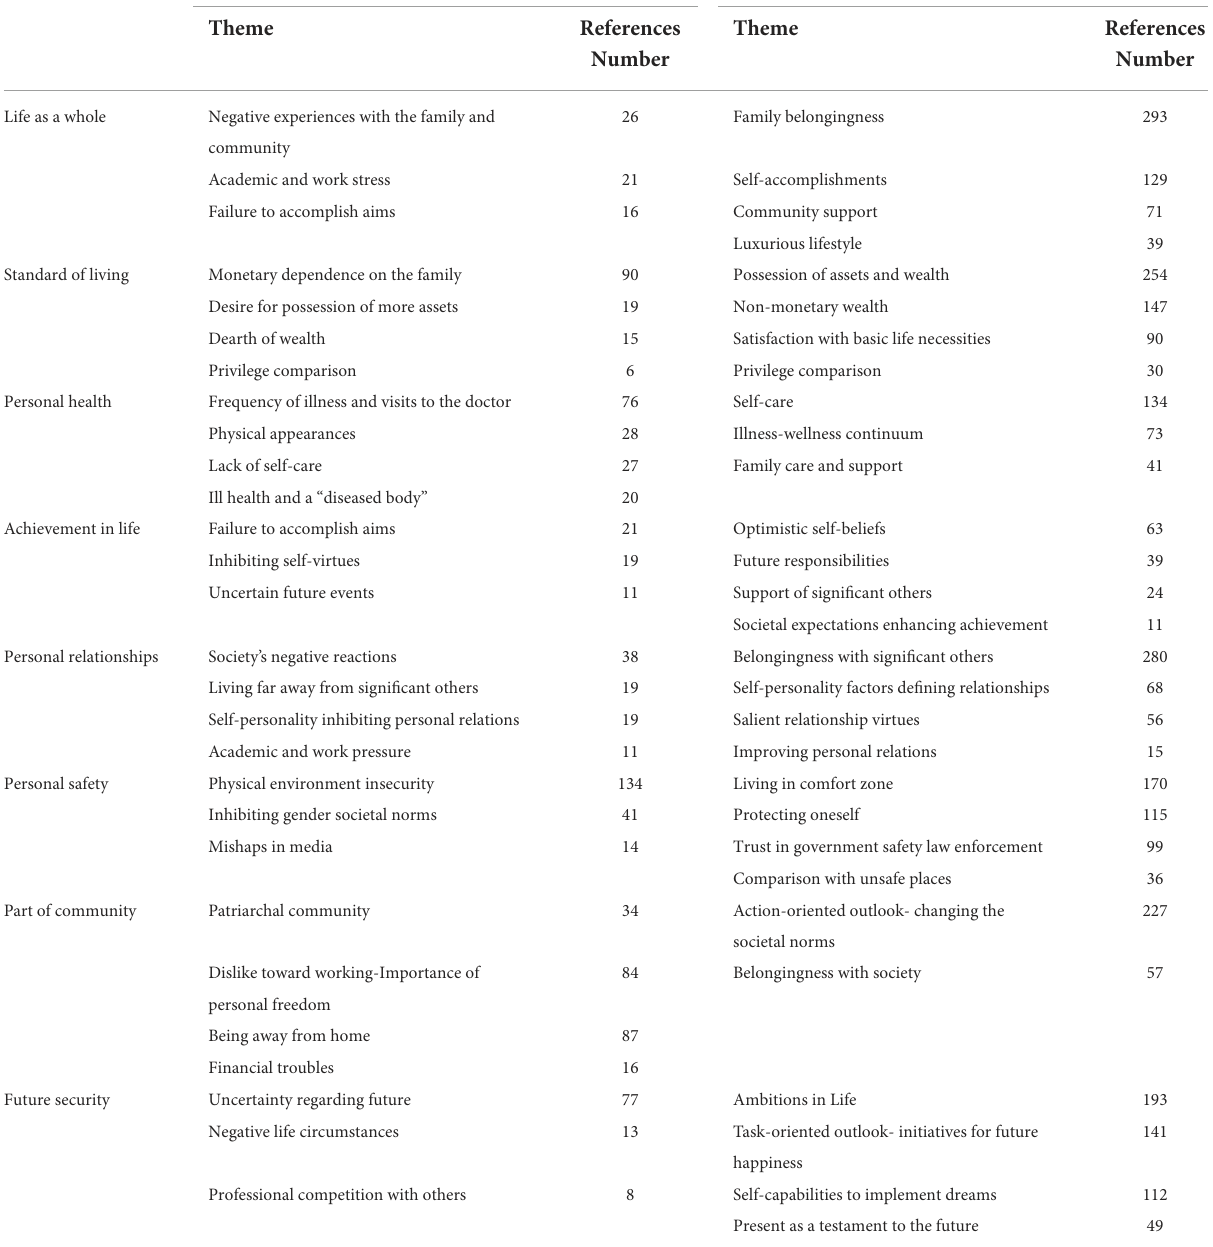
TABLE 3 Content analysis depicting inhibitors and facilitators of